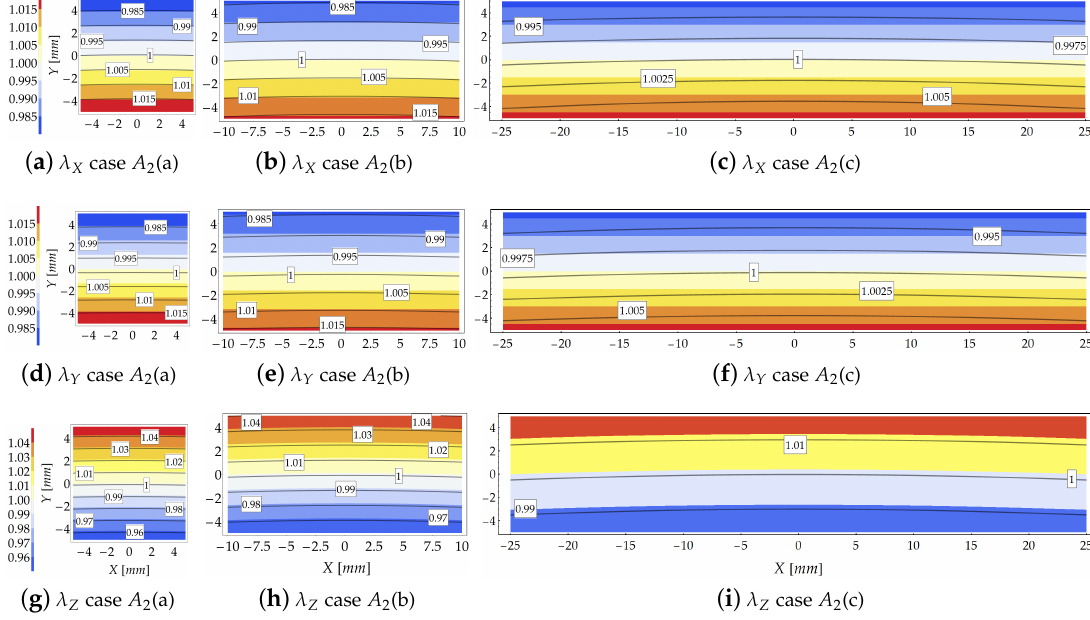
Figure 10. Study case A 2 at increment 3 ( µ = 100): Comparison in terms of stretches provided by the theoretical model (contour plot) and the FE solution (solid isolines with boxed